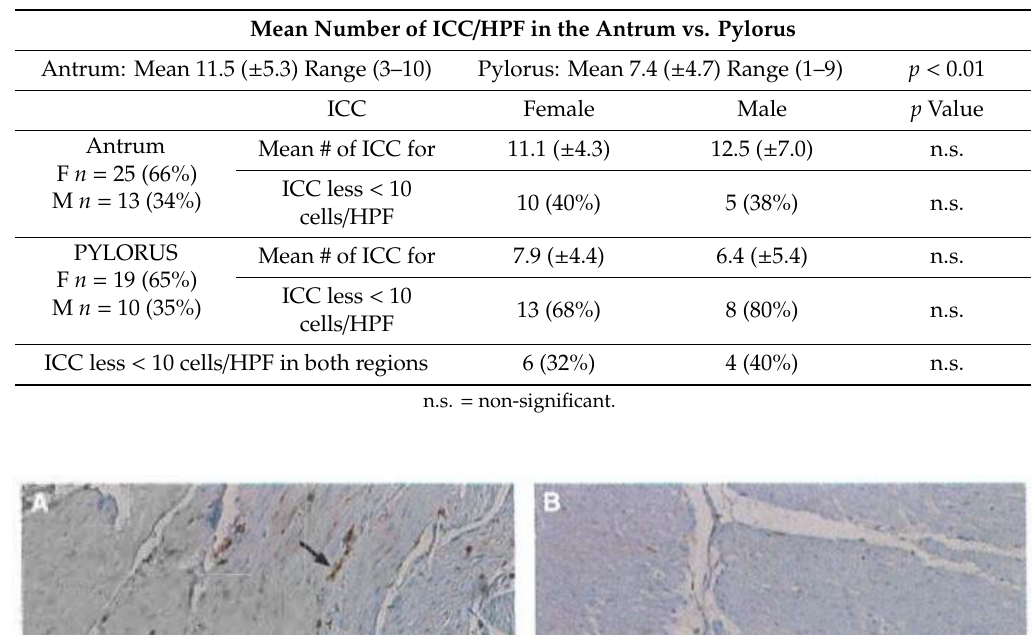
Table 1. Results of ICC status based on gender and gastric region in diabetic gastroparetic patients who received gastric electrical stimulation systems and pyloroplasty for their severe gastroparesis (GP) symptoms.